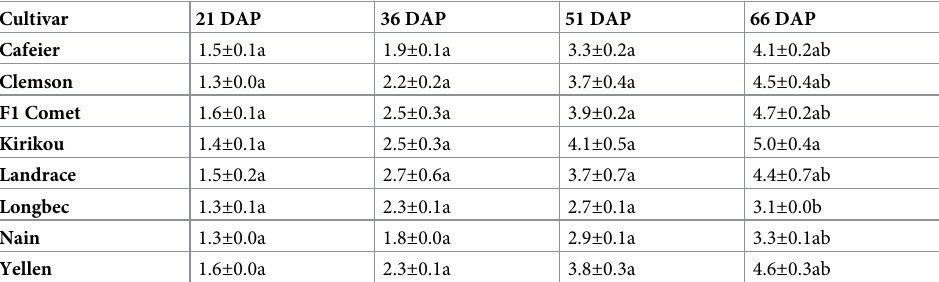
F1 Comet was significantly taller (64.36 cm) than the other cultivars at 66 DAP. The Land- race was second in terms of height (42.25 cm), which was not significantly different from Clemson spineless, Kirikou, Yellen, Longbec, but significantly different from Cafeier and Nain. Stem circumference . All the okra cultivars recorded increasing values for stem circumfer- ence across the different weeks of measurement (Table 7). Cultivars did not record any signifi- cant results at the 21, 36 and 51 DAP respectively. At 66 DAP, Kirikou recorded the highest value (5.00 cm) for stem circumference, which was significantly different from Longbec, but not significantly different from the other cultivars examined. Number of leaves . Okra cultivars showed robust growth throughout the sampling period for the number of leaves (Table 8). At 21 DAP, the Landrace and F1 Comet recorded the highest values (4.67), which was not significantly different from the other cultivars but was signifi- cantly different from Longbec. Cultivars did not record any significant results at 36 and 51DAP respectively. At 66DAP, Yellen recorded the highest value (13.42), which was not sig- nificantly different from the other cultivars but was significantly different from Clemson spineless. Leaf area . Analysis of variance revealed that okra cultivars recorded significant results at 21, 36 and 51 DAP respectively (Table 9). At 21 DAP, F1 Comet recorded the highest leaf area (30.93 cm 2 ), which was not significantly different from Kirikou, Yellen, Landrace, and Clem- son spineless but significantly different from Longbec, Nain and Cafeier. At 36 DAP, F1 Comet recorded the highest leaf area (181.8 cm 2 ), which was not significantly different from Table 7. Stem circumference of okra cultivars.